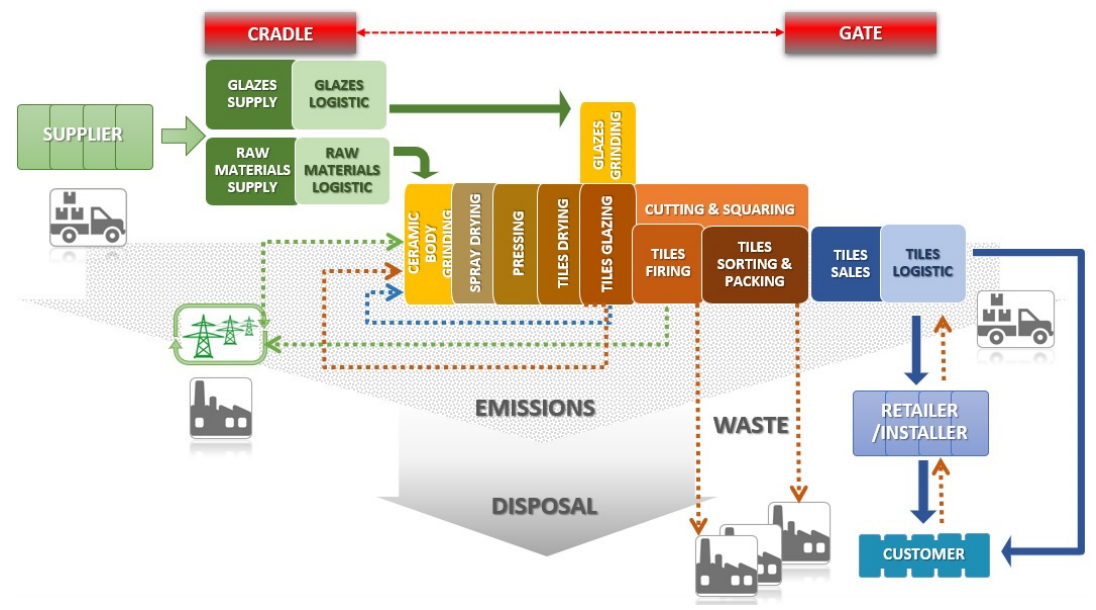
Figure 1. Ceramic production circular process flow (source: our elaboration).